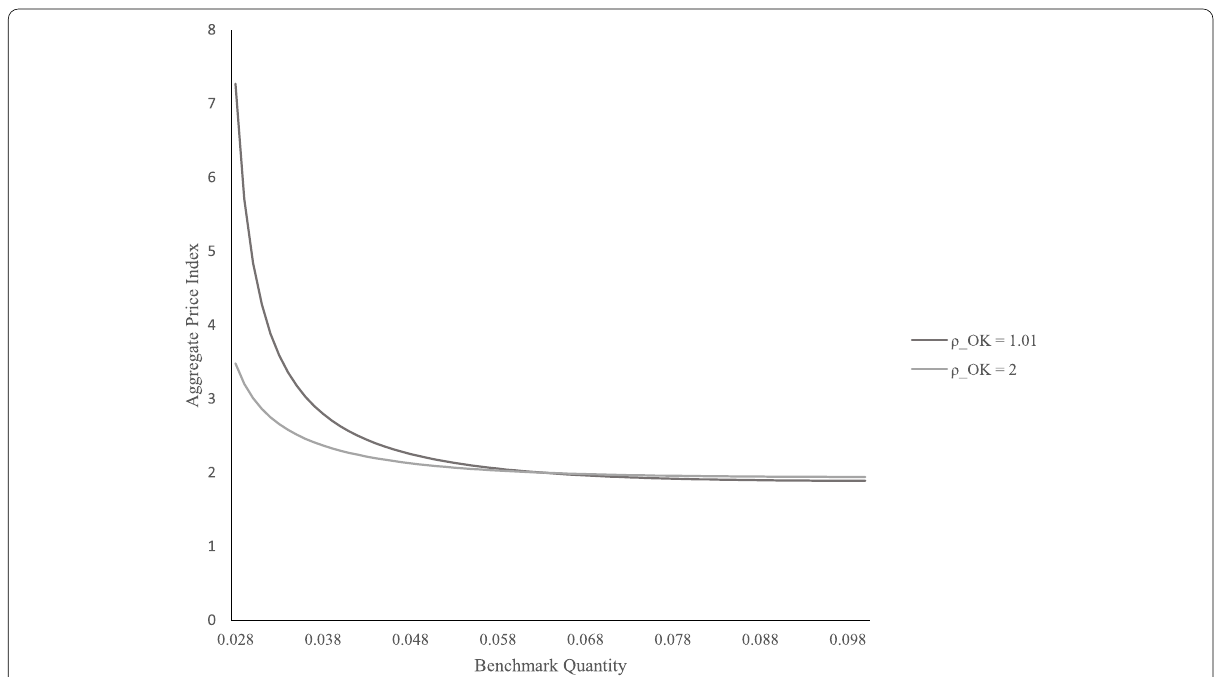
Fig. 3 Demand curve shift of Oklahoma cannabis market: due to the differences in elasticity of substitution between medical and recreational